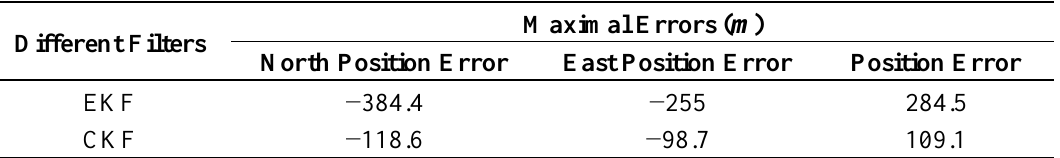
Table 3. Simulation results with different